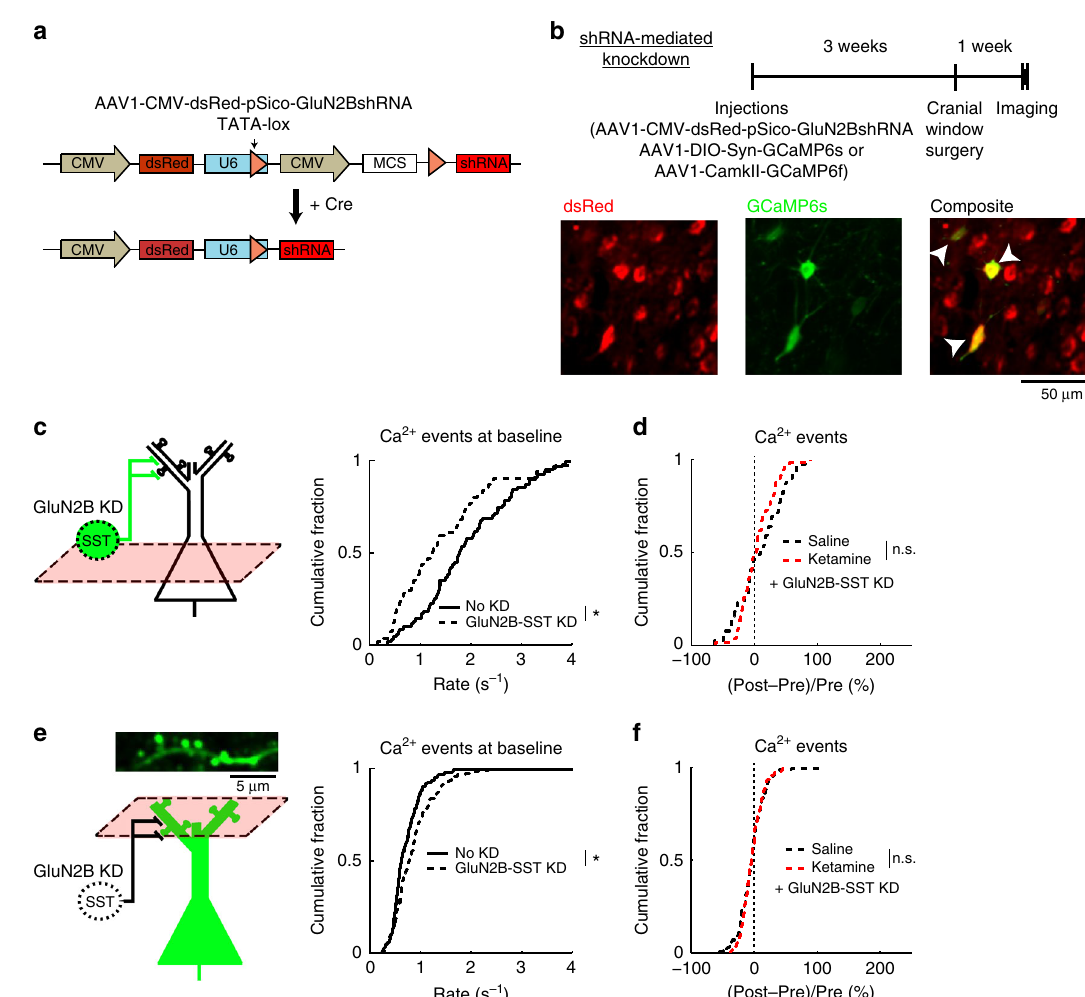
Fig. 5 GluN2B expression in SST interneurons mediates effect of ketamine on dendritic spine calcium. a Schematic of AAV1-CMV-dsRed-pSico- GluN2BshRNA (standard AAV cassettes not drawn) for Cre-dependent expression of shRNA against GluN2B. b Top, timeline for experiments involving selective knockdown of GluN2B expression in SST interneurons (GluN2B-SST KD). Bottom, in vivo two-photon image of ubiquitous dsRed expression (left), Cre-dependent GCaMP6s expression (middle), and a composite image (right). Arrowheads, cells that expressed both dsRed and GCaMP6s. c The rate of spontaneous calcium events for GCaMP6s-expressing SST interneuron cell bodies with or without GluN2B-SST KD (GluN2B-SST KD: 1.5 ± 0.2 Hz, control SST-IRES-Cre animals with no KD: 1.9 ± 0.1 Hz, mean ± s.e.m.; P = 0.04, two-sample t-test). For GluN2B-SST KD, n = 58 cells from 3 animals. For control animals, n = 72 cells from 3 animals. d The normalized difference in the number of spontaneous calcium events GCaMP6s-expressing SST interneuron cell bodies, for GluN2B-SST KD with ketamine or saline injection. Normalized difference was calculated as post-injection minus pre-injection values normalized by the pre-injection value (ketamine (10 mg/kg) with GluN2B-SST KD: 2 ± 4%, saline with GluN2B-SST KD: 7 ± 6%, mean ± s.e.m.; P = 0.46, two-sample t - test). For ketamine, n = 58 cells from 3 animals. For saline, n = 39 cells from 3 animals. e Same as ( c ) for GCaMP6f-expressing apical dendritic spines (GluN2B-SST KD: 0.85 ± 0.03 Hz, mean ± s.e.m., control SST-IRES-Cre animals: 0.73 ± 0.04 Hz, mean ± s.e.m.; P = 0.01, two-sample t-test). For GluN2B- SST KD, n = 277 spines from 4 animals. For control animals, n = 118 spines from 3 animals. f Same as ( d ) for GCaMP6f-expressing apical dendritic